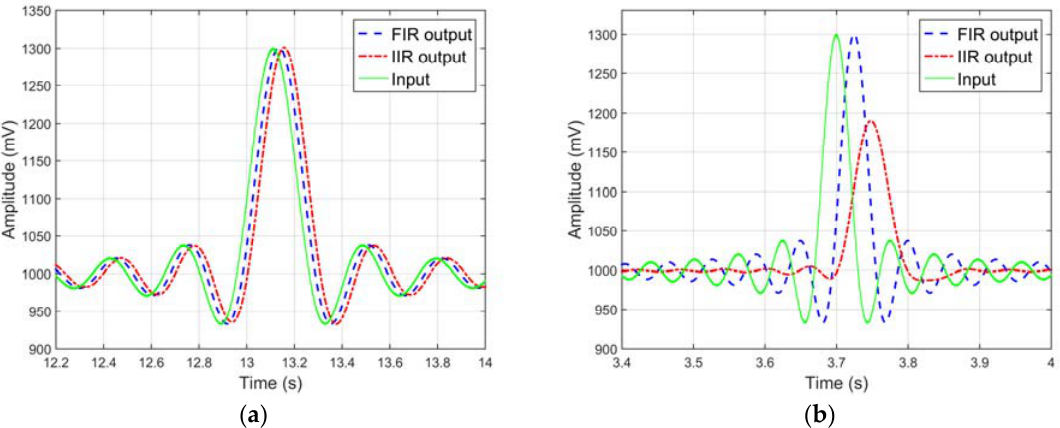
Figure 5. FIR and IIR filters’ responses for different input signals. ( a ) Response to the 3.5 Hz sinc ( t ); and ( b ) Response to the 15 Hz sinc ( t ).